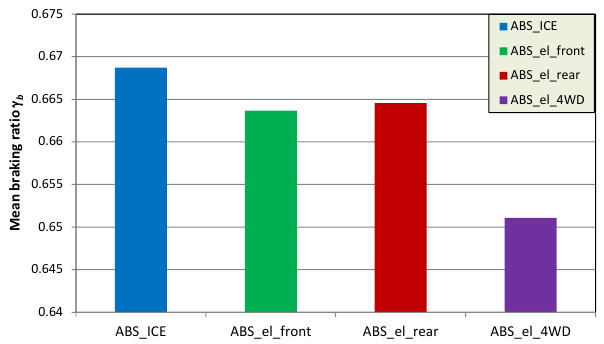
Fig. 10. Mean braking ratio in braking the vehicle straight ahead on a road with homogeneous high adhesion coefficient [own research]